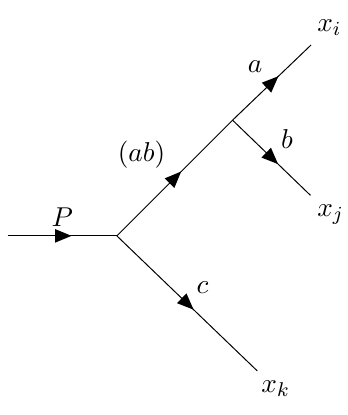
Figure 1 . The iterated single-collinear contribution to the triple collinear splitting